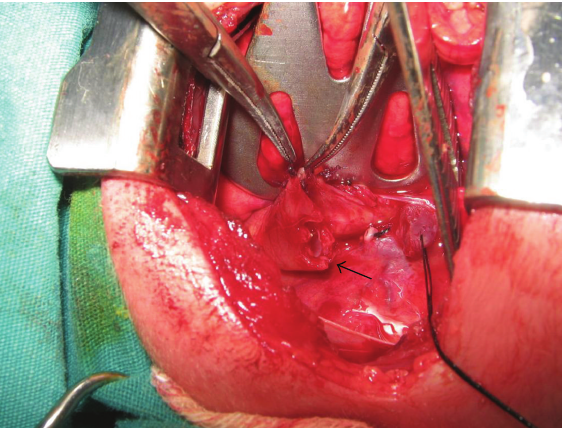
Figure 1: The proximal esophageal pouch opened with plus “+”— shaped incision.